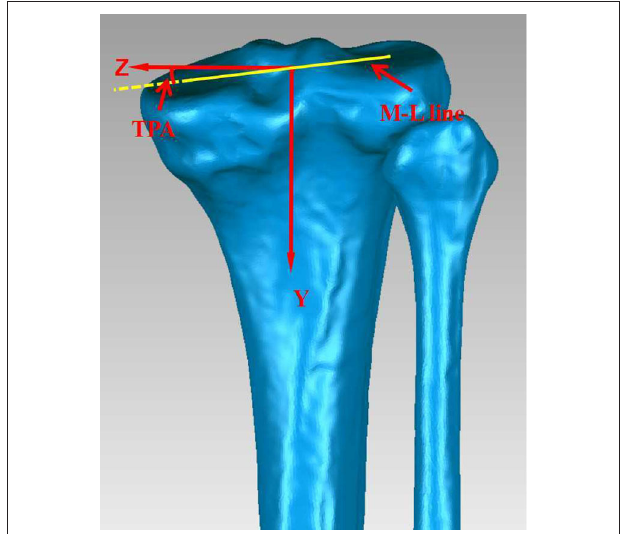
FIGURE 2 | 1.LE line, 2.MLE line, 3.Akagi’s line, 4.1/3 line.